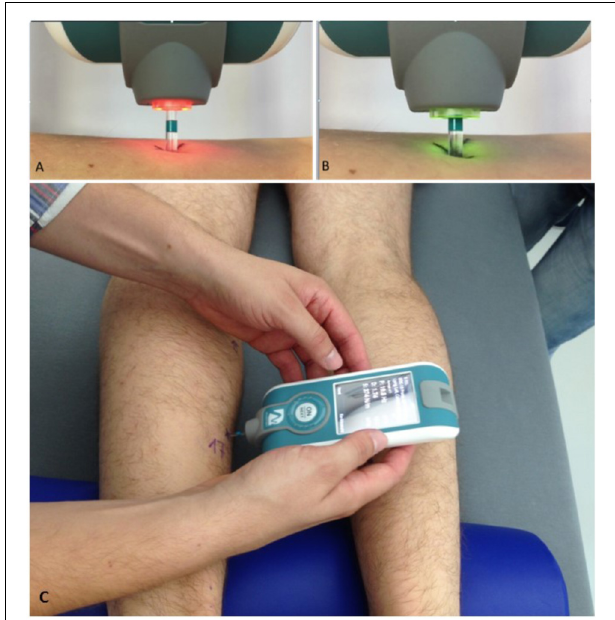
FIGURE 2 | Experimental set-up of myotonometric measurements used in RSL bed rest. Upper panel (A,B) shows magnifications of color-coded flat-end probe to show (A) inactivated (orange light) and (B) activated (green light) sensor probe (vertical tolerance 3 mm) sensor tip. In (A) , orange probe shows (re-)positioning phase (0.40N), in (B) , green probe shows oscillation acceleration phase ongoing (with x 0.8 s mechanical force intervals). (C) Shows the device in perpendicular position with probe gently touching a premarked dorsal leg skin measure point (MP17, soleus) to collect natural oscillation signal patterns in a bed rest study participant lying prone on his own 6 ◦ HDT matress at full rest in his study room. Note half-pillow support for standardization of ankle position during sessions. Credit: Myoton AS and D.